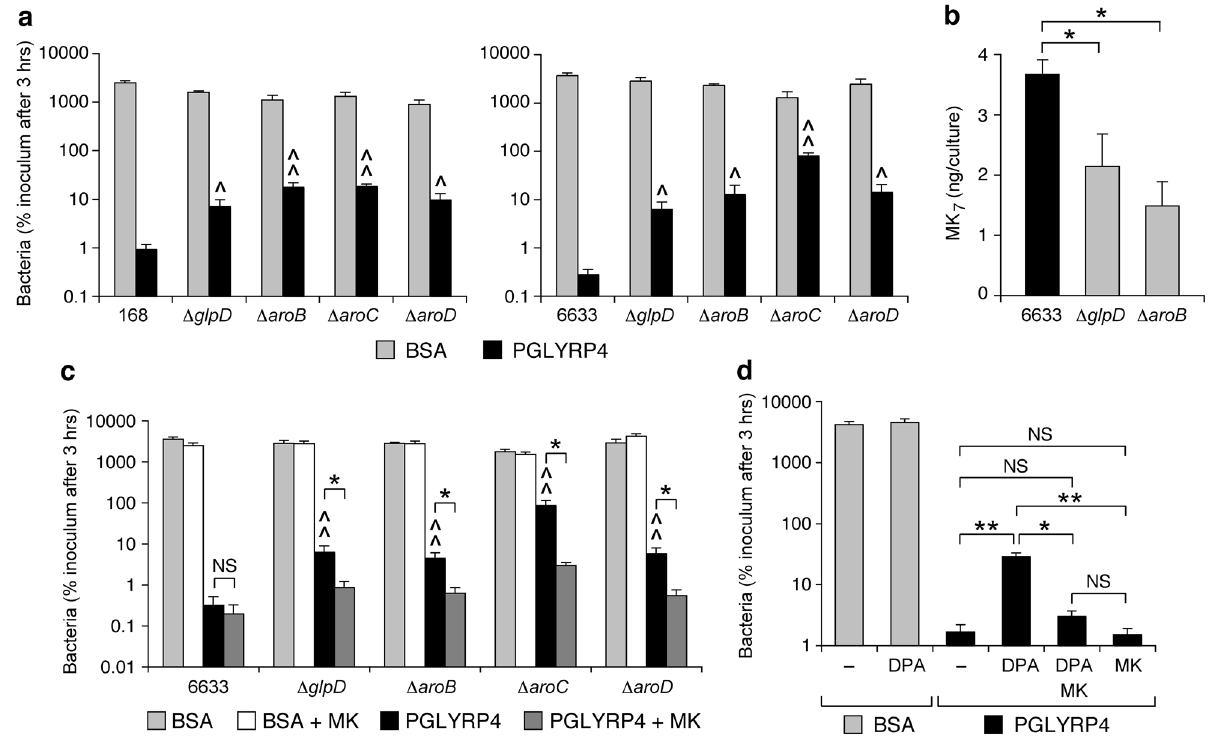
Figure 3. B. subtilis Δ glpD and Δ aro mutants have increased resistance to PGLYRP4-induced killing ( a ), lower amounts of menaquinone (MK) ( b ), exogenous MK increases their sensitivity to PGLYRP4-induced killing ( c ), and MK synthesis inhibitor DPA inhibits PGLYRP4-induced killing, which is restored by addition of exogenous MK ( d ). The results are means ± SEM of the numbers of bacteria (CFU) expressed as percent of initial inoculum (100%) ( a , c , d ) or of amounts of MK 7 /culture ( b ) and are from 4 to 6 ( a , c , d ) or 3 ( b ) experiments (biological replicates). B. subtilis 6633 was used in ( d ). ^ P < 0.05, ^^ P < 0.001 mutant vs parental strain; NS not significant ( P > 0.05); * P < 0.05, ** P < 0.001 as indicated by